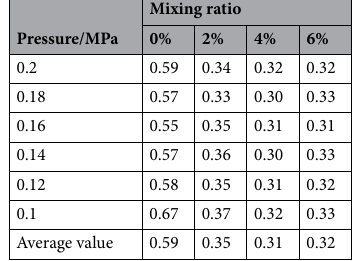
Table 5. PDEV value/breakdown voltage